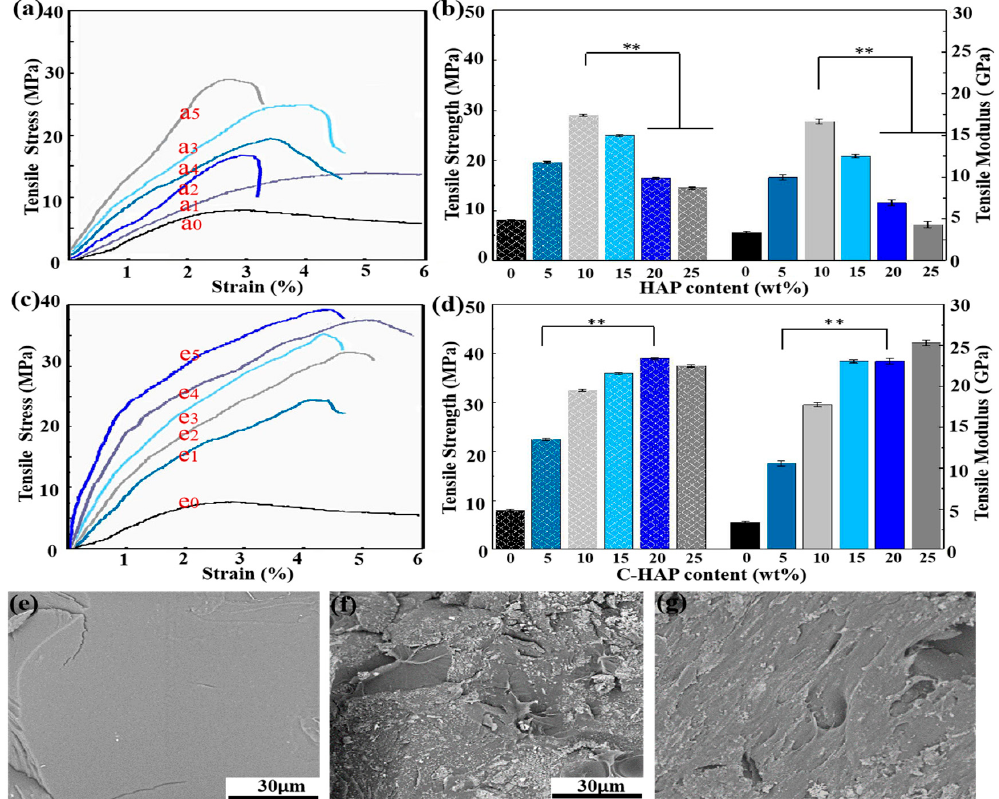
Figure 4. Typical tensile strain–stress curve of PLLA sca ff olds with di ff erent contents of ( a ) C-HAP, ( b ) HAP, ( c ) tensile strength and ( d ) tensile modulus of the sca ff olds, fracture surface of ( e ) PLLA sca ff old, ( f ) PLLA / 20% HAP sca ff old, ( g ) PLLA / 20% C-HAP sca ff old.(where ** representing p <